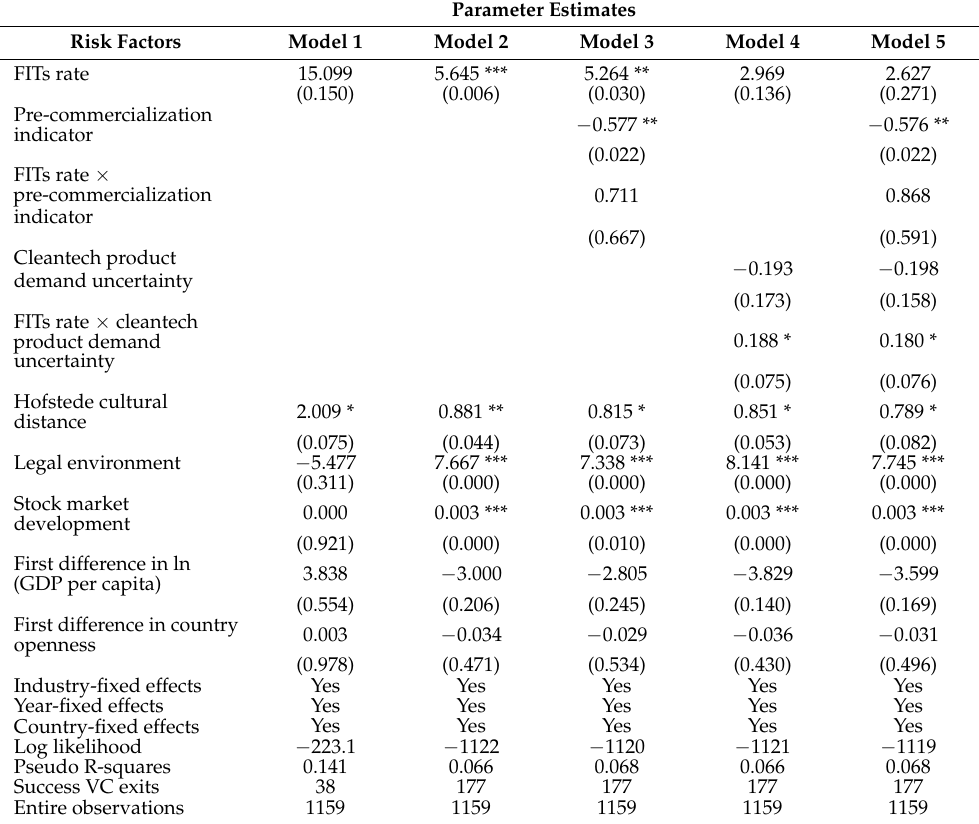
Table 5. Cox hazard analysis of the sample of 1159 VC-backed cleantech start-ups in IPO and